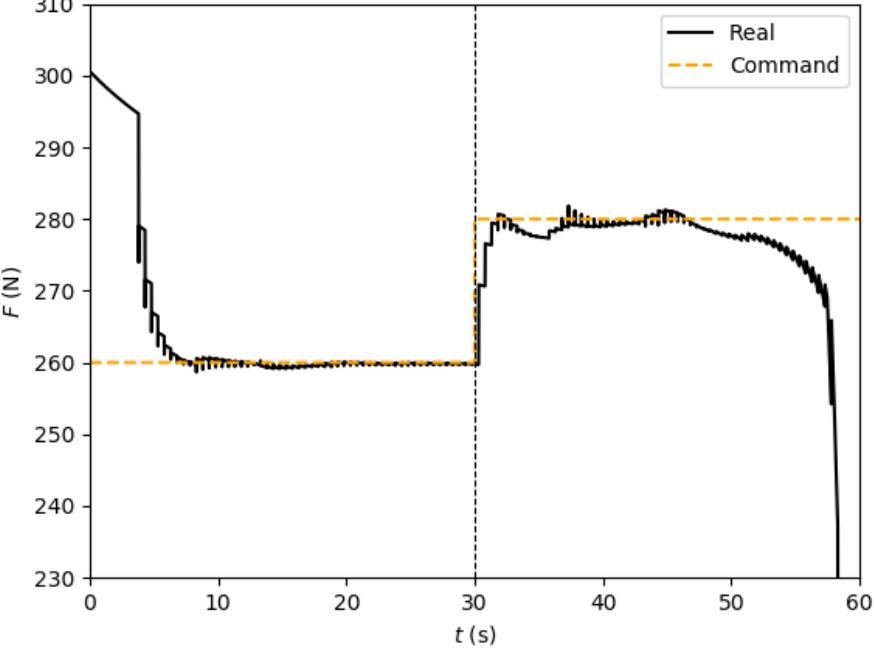
Figure 34. Thrust profile, feedback with complete regulation law, case 2, ds = 3